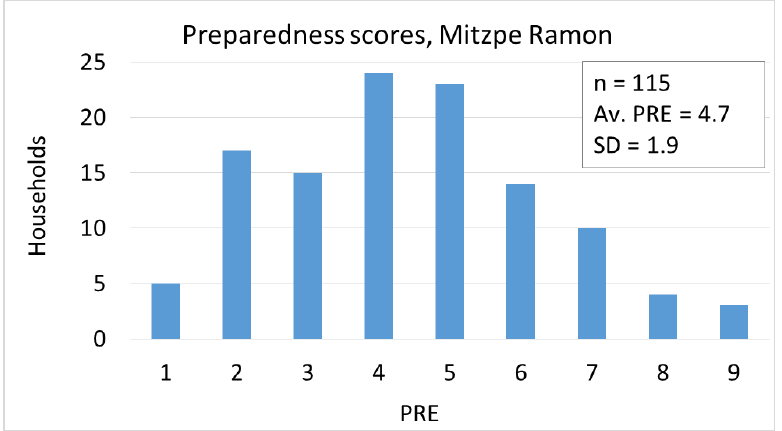
Figure 2. Preparedness of residents in Mitzpe Ramon. The majority of surveyed households (85%) got a low to moderate preparedness score (PRE = 1 – 6) and only 6% of the households reported very got a low to moderate preparedness score (PRE = 1–6) and only 6% of the households reported very high preparedness (PRE > 7). high preparedness (PRE >